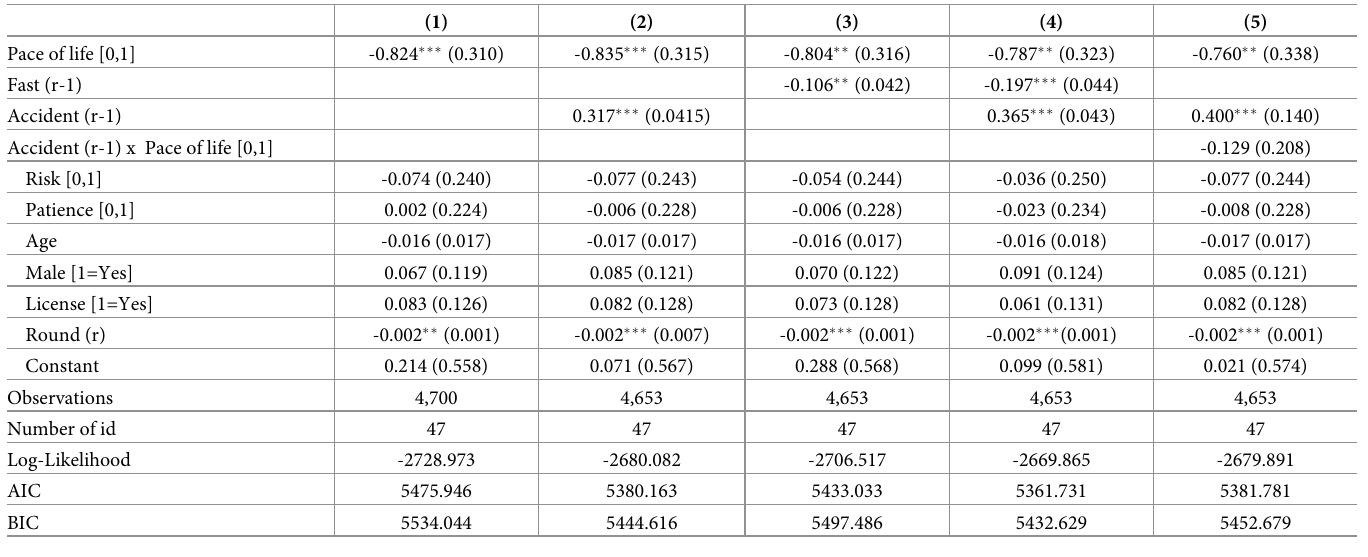
Table 6. Random-effects regression for strategy changes in